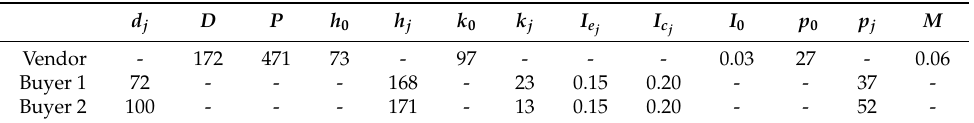
Table 5. Input data for Example